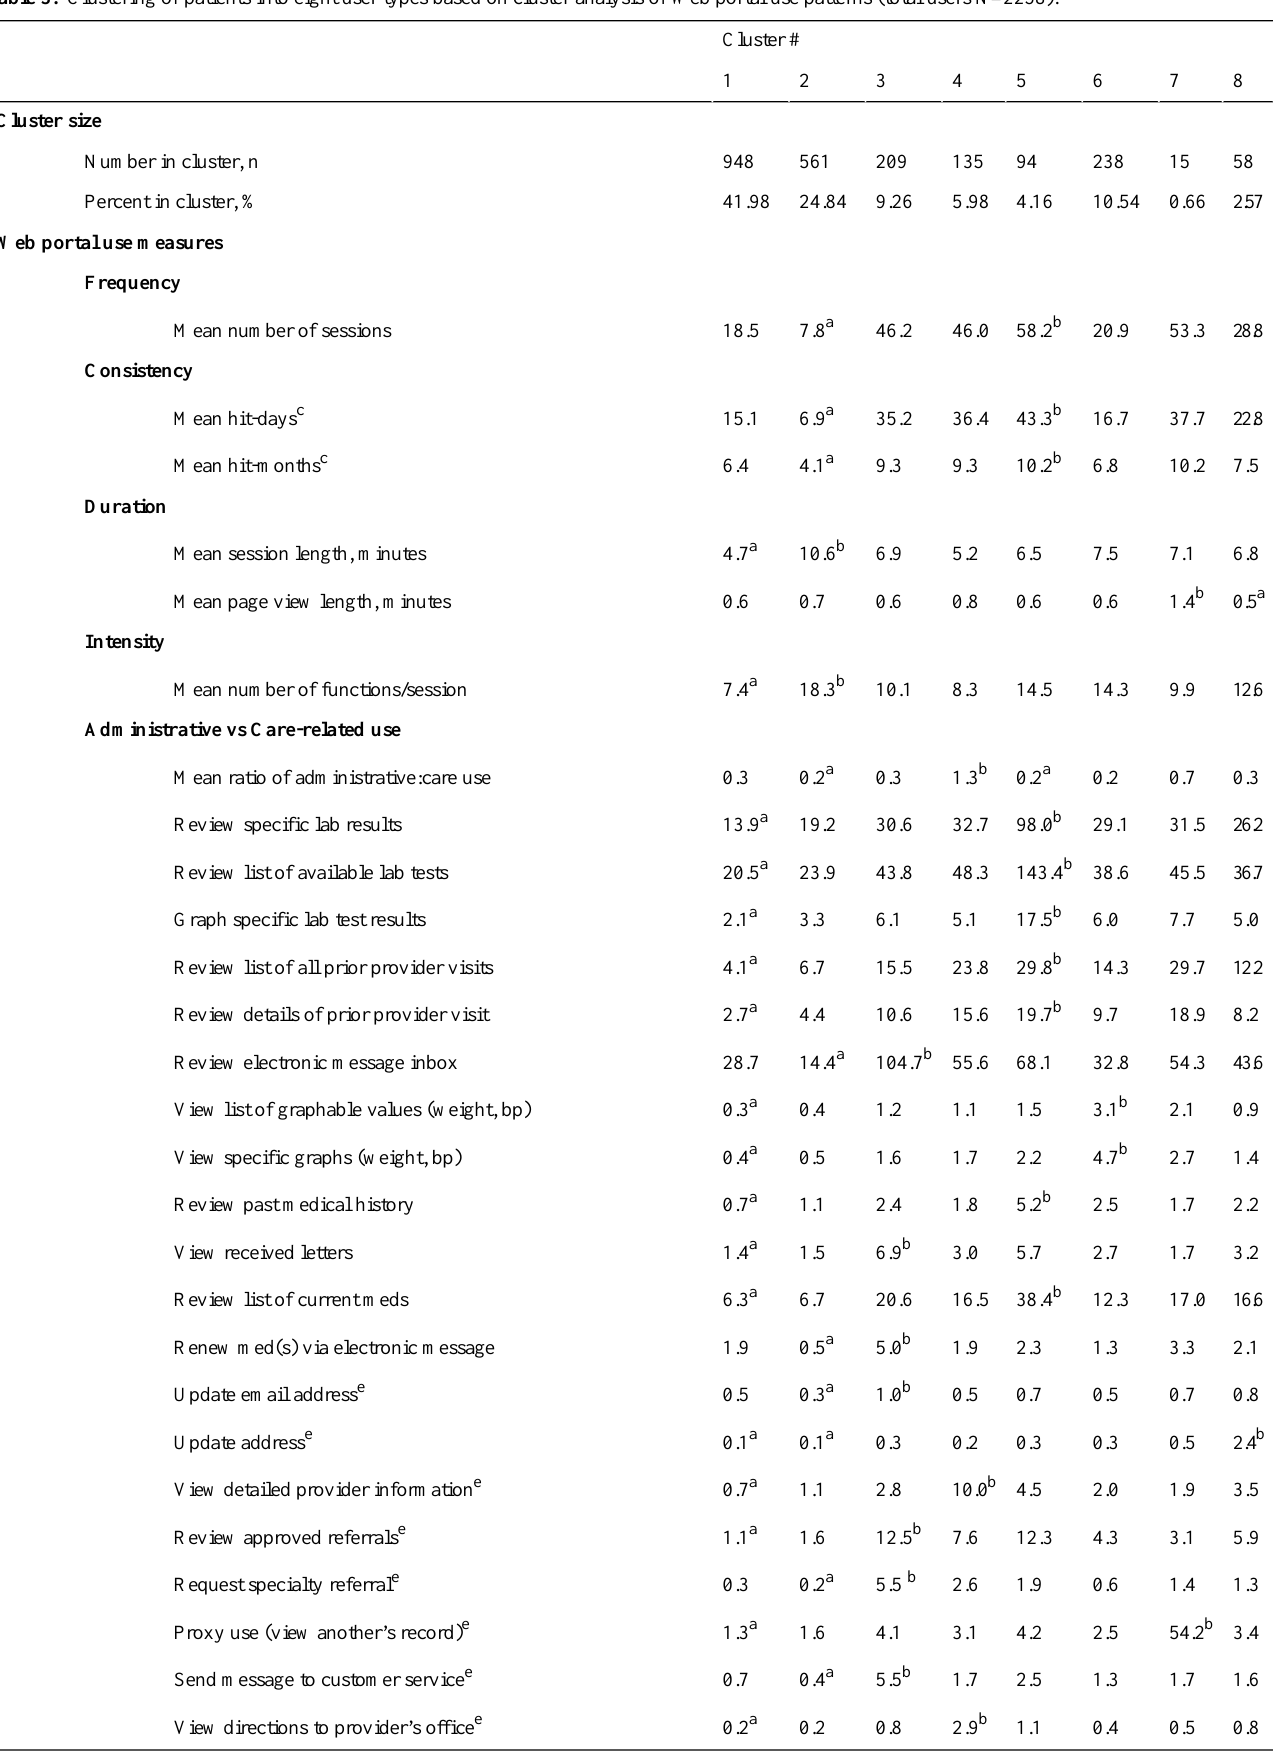
Table 3. Clustering of patients into eight user types based on cluster analysis of Web portal use patterns (total users